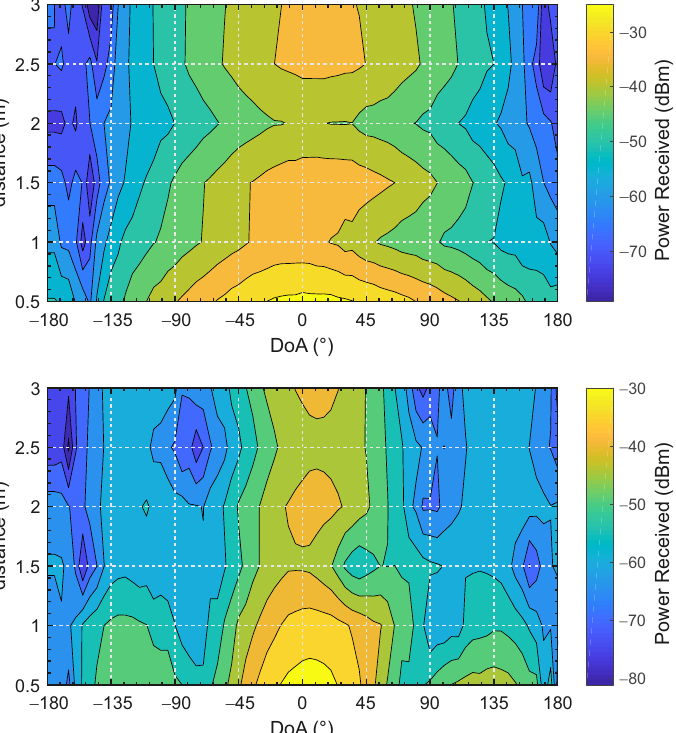
Figure 8. Power distribution relative to antenna #1 in the case of a severe interference from the image antenna, at 2.45 GHz ( top ) and 5.2 GHz ( bottom